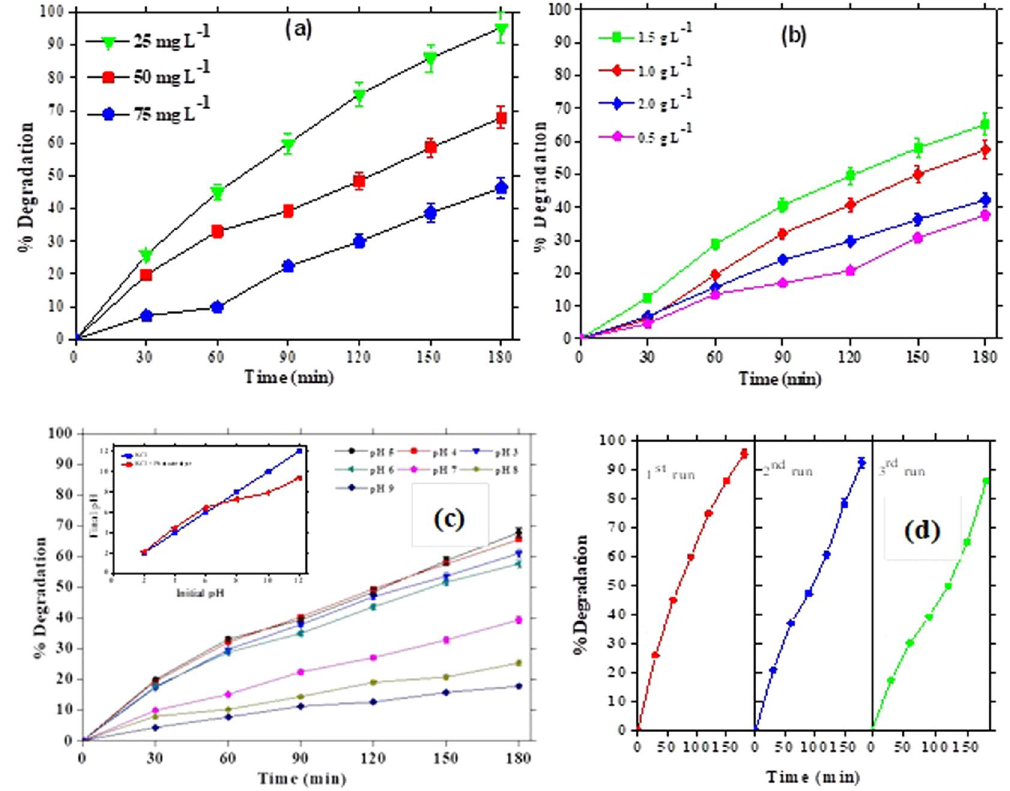
Figure 10. Photocatalytic activity influenced by; ( a) initial 2-CP concentration; ( b) catalyst dosage ; (c) variable solution pH; ( d) catalysts